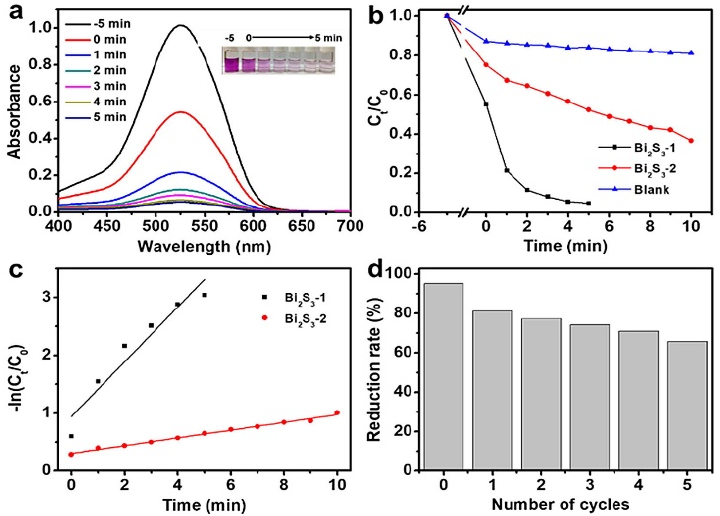
Figure 18. ( a ) Absorption spectra of RhB solution at different times of photodegradation with Bi 2 S 3 -1 (the inset in the right corner is an image of RhB solution before and after photodegradation). ( b ) Variation of RhB concentration with photodegradation time in the existence of various photocatalysts (Bi 2 S 3 − 1, Bi 2 S 3 − 2, and TiO 2 ) under visible light. ( c ) − ln (Ct/C0) versus time curves of Bi 2 S 3 − 1, Bi 2 S 3 − 2 and TiO 2 . ( d ) The durability tests of Bi 2 S 3 − 1 for photodegradation of RhB [182].